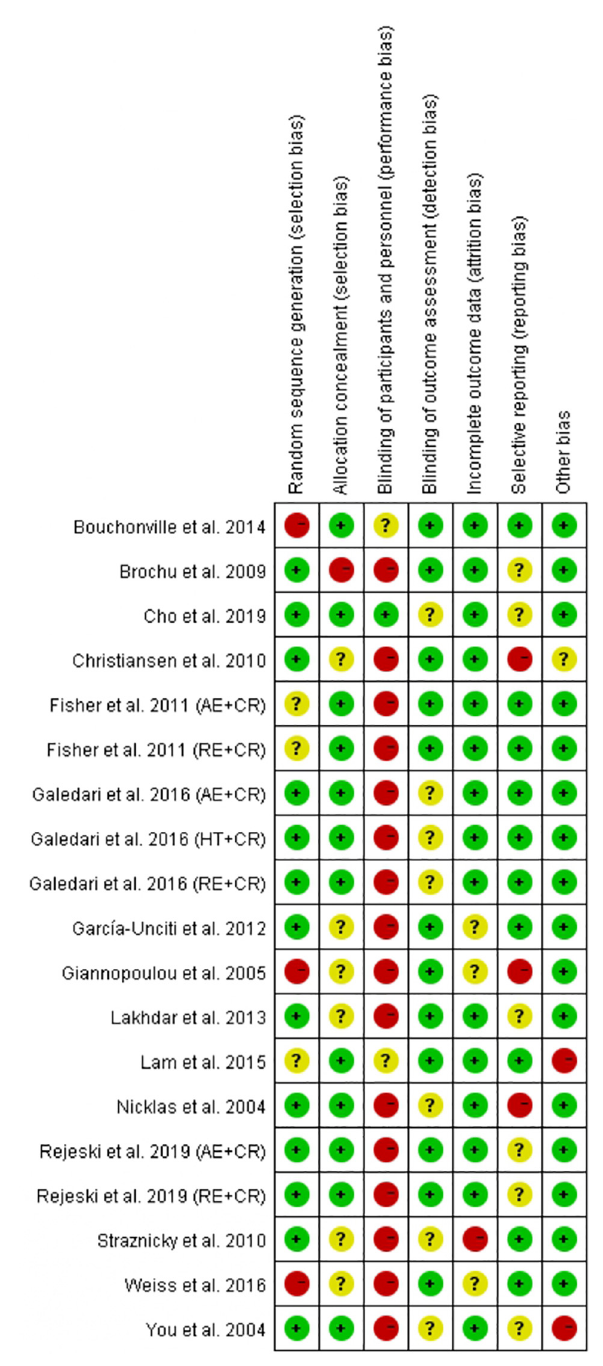
physical inactivity, poor diet, nighttime blue light exposure, smoking, and psychological stress are reported to promote systemic inflammation. Therefore, lifestyle modifications may reduce inflammatory proteins and improve metabolic